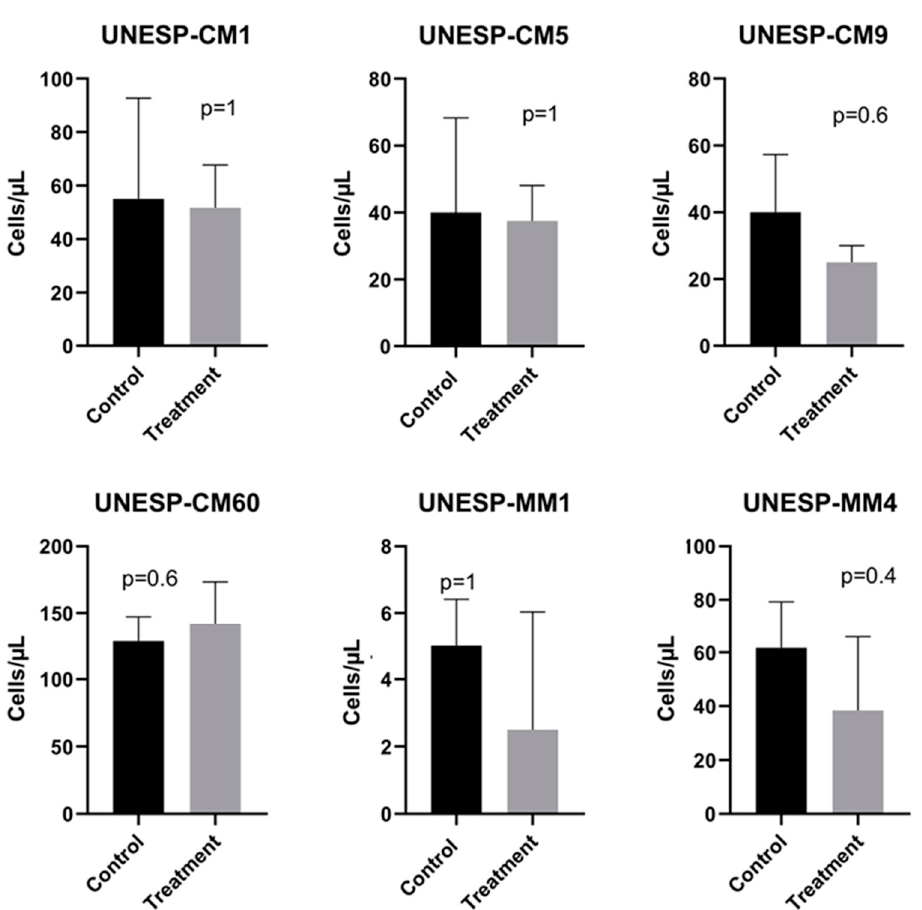
Figure 5. Concentration (cells/ µ L) of cells in the wells of each cell culture after the migration assay protocol. The Mann–Whitney test was used to compare the migration of the control and treatment groups.